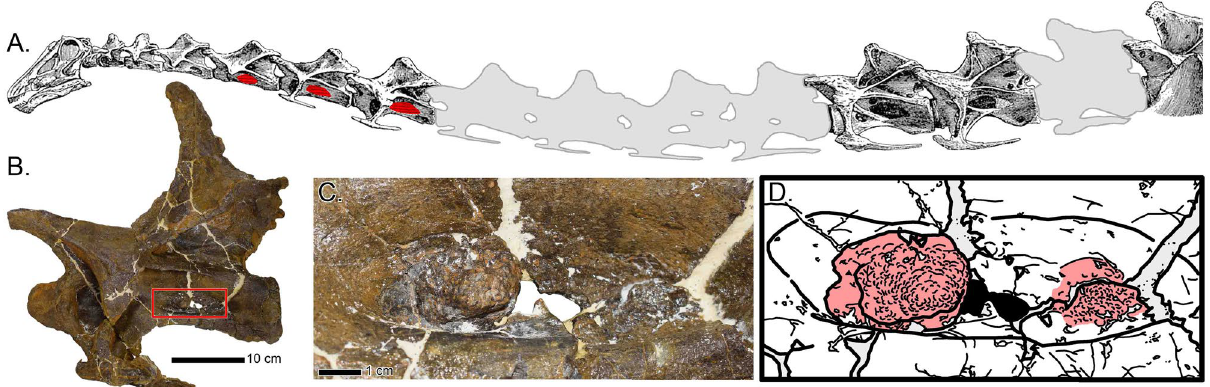
Figure 1. Pathologic pneumatic tissue in MOR 7029. ( A ) Schematic map of the neck of Diplodocus (Ref. 104 ; bones not present in grey), with the pathologic structures denoted in red. ( B ) Cervical 5 of MOR 7029 with red box highlighting the pathologic structure; close up in ( C ) with interpretative drawing in ( D ) (by DCW) (pathology in